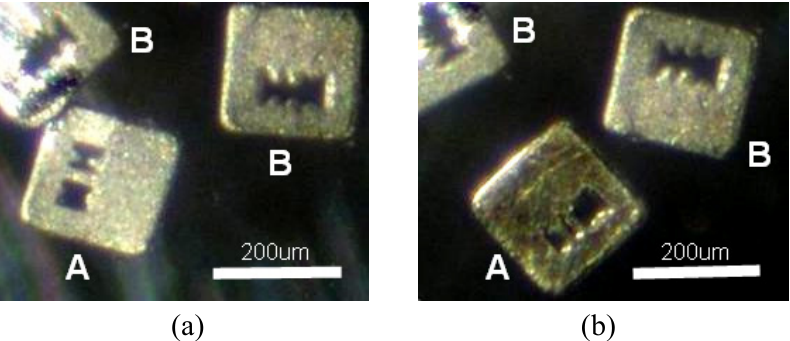
Figure 8. Multiplex detection of ferromagnetic coded micro-carriers with unknown antibody: (a) before hybridization; (b) after hybridization.